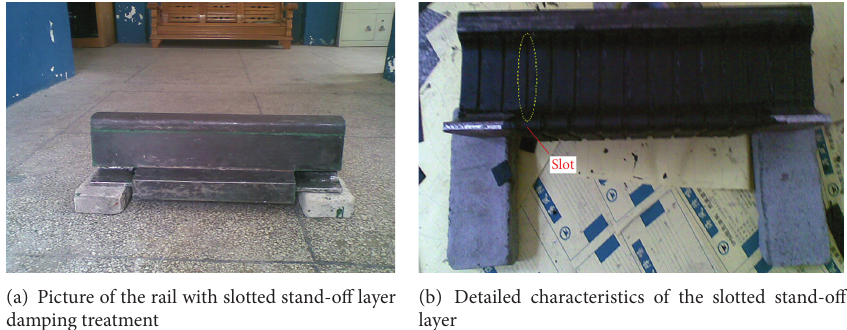
Figure 10: Schematic plot of rail with the slotted stand-off layer damping treatment.